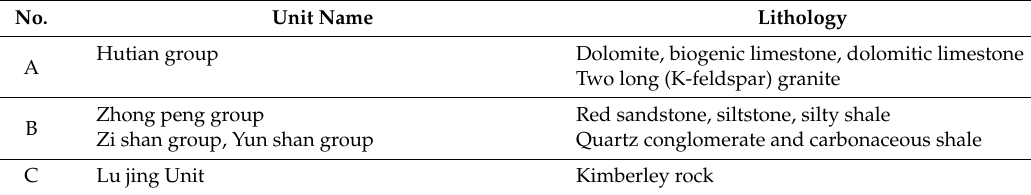
Figure 2. The geological map of the Anyuan County in China.